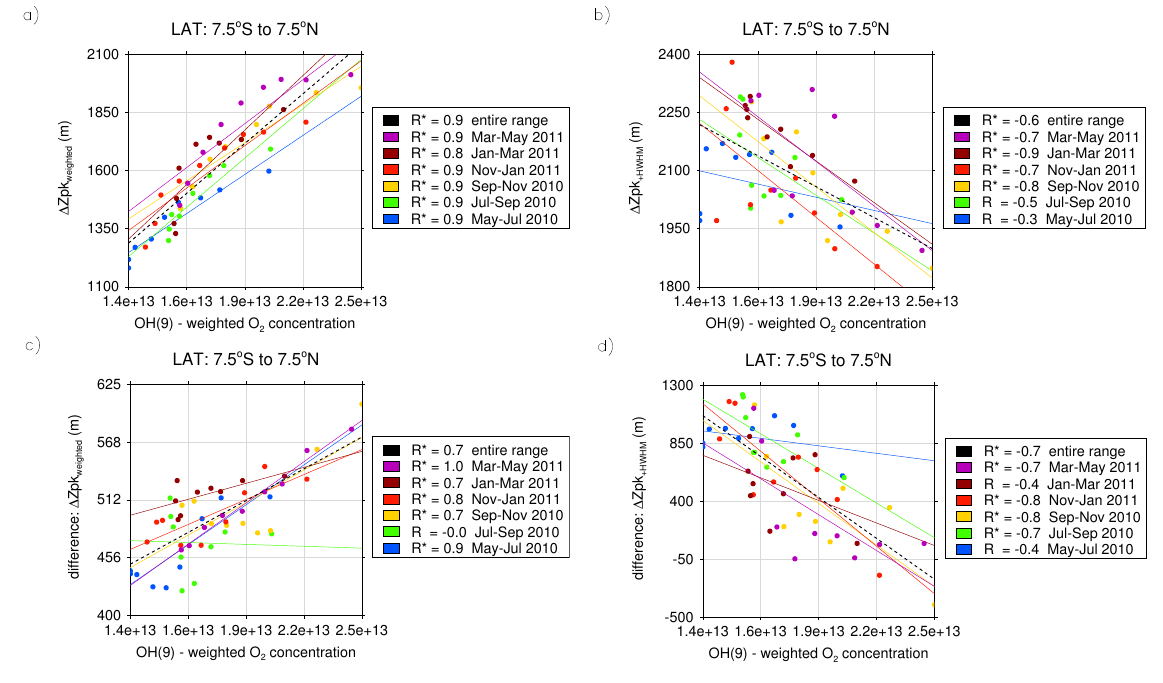
Figure 10. Similar to Fig. 9 but referring to the O 2 quenching Fig. 10: Similar to Fig. 9 but referring to the O